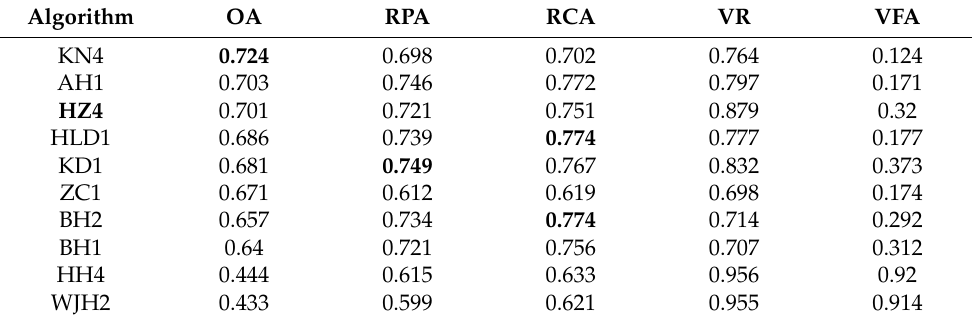
Table 1. MIREX correlative results in 2019 and